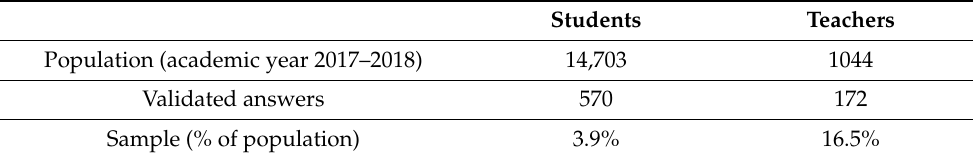
Table 3. Population and data samples, from students and teachers.